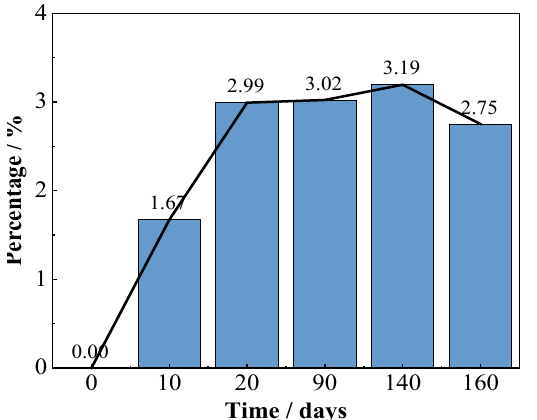
Figure 5. Analysis result of areas of micro-cracks and holes in surface micrographs of the FW-2 coating.